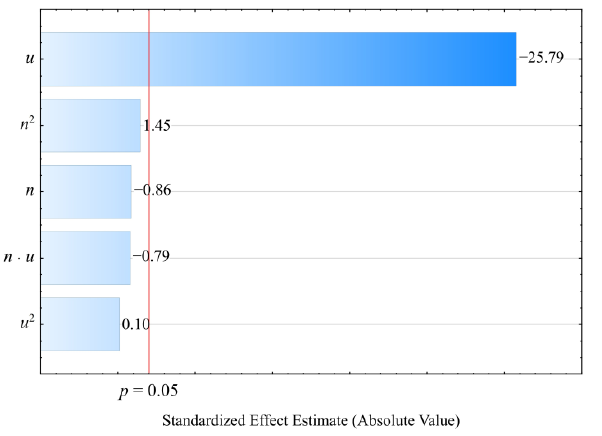
Figure 2. Pareto charts of the standardized effects for the empirical model of transverse shrinkage S T ; the vertical line in the plot corresponds to the arbitrarily chosen level of significance ( p = 0.05).